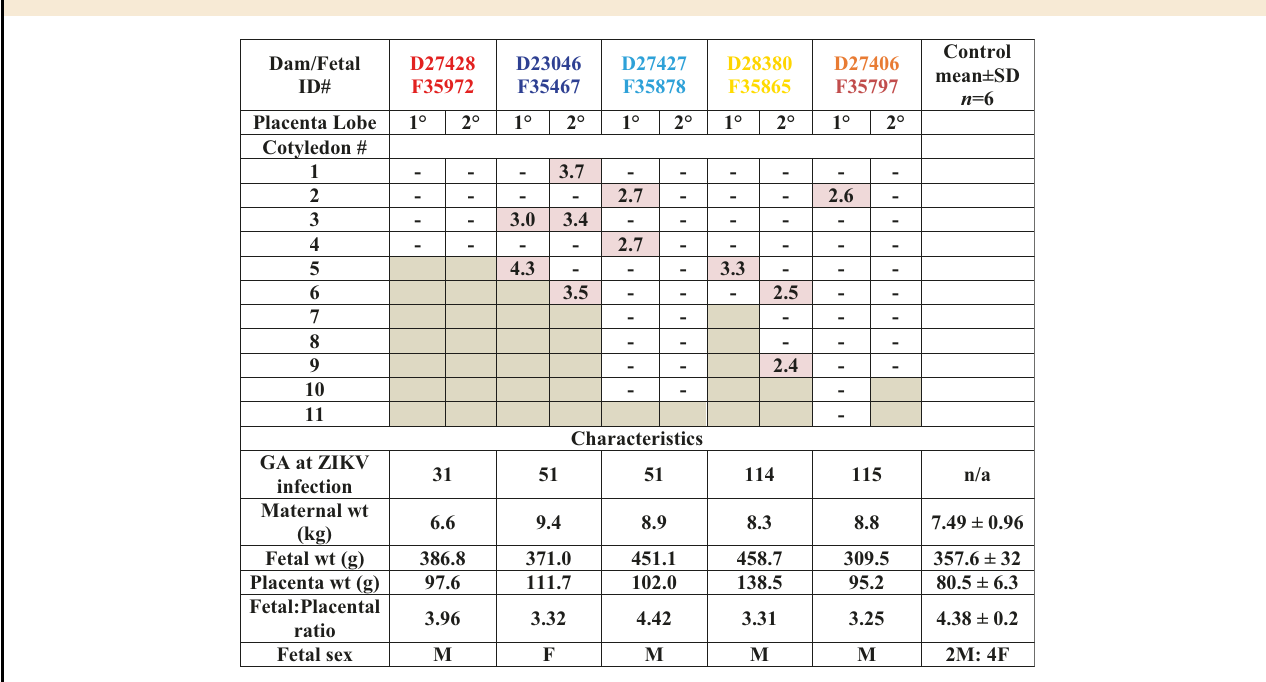
Table 1 Detection of ZIKV RNA in placenta and maternal, placental and fetal